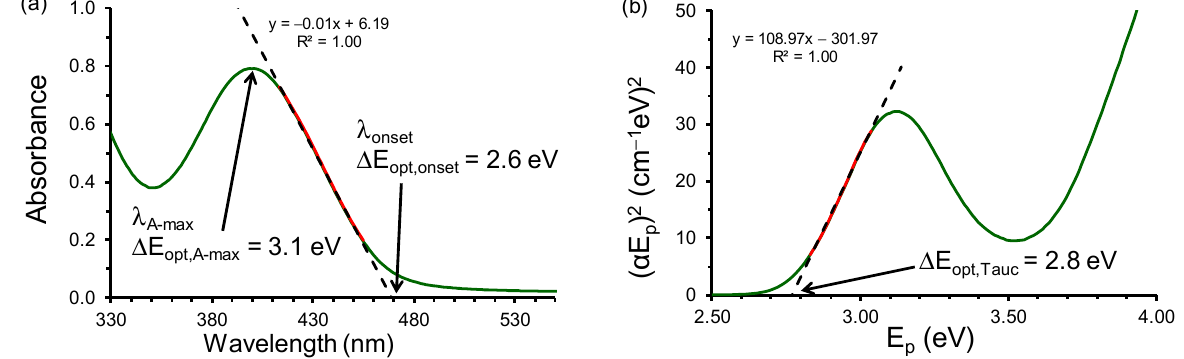
Figure 9. ( a ) The experimental UV of ( 5 ) in DMSO illustrating the determination of the onset (469 nm) and maximum absorbance (401 nm) positions that were used to calculate the experimental optical band gap ( Δ E opt ). ( b ) Tauc plot of ( 5 ) showing the determination of the experimental optical band gap ( Δ E opt,Tauc ).